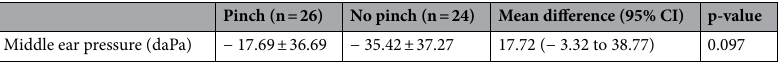
Table 3. Middle ear pressure after